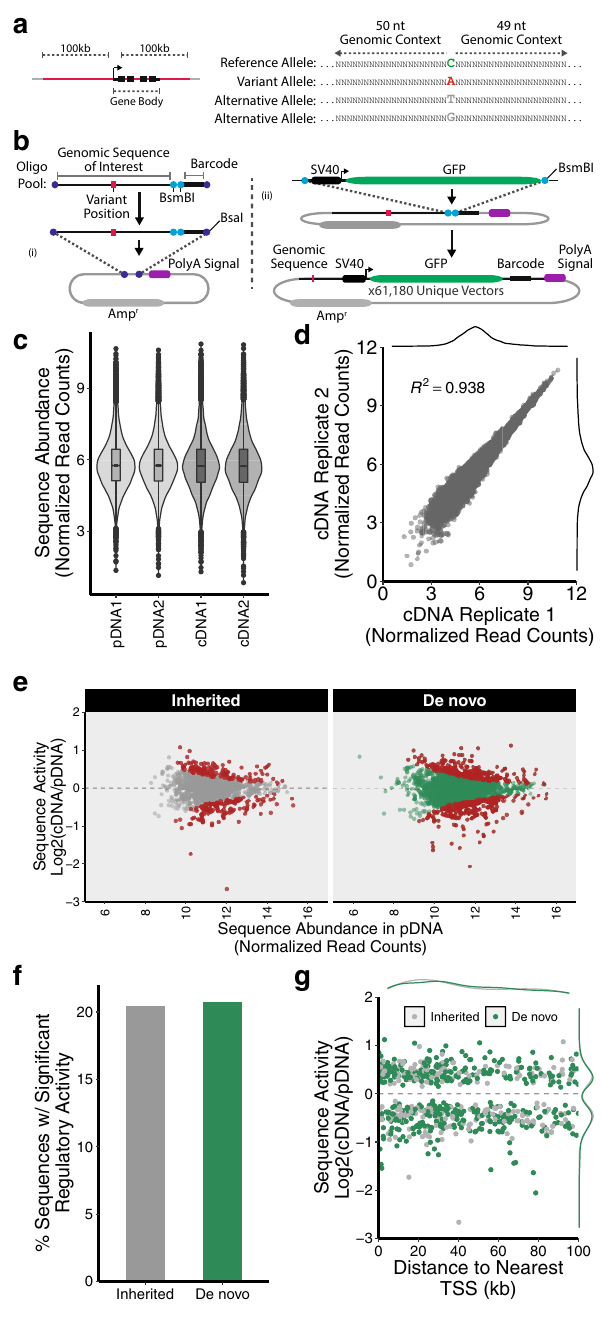
Figure 2. Profiling the regulatory capacity of genomic sequences using a massively parallel reporter assay. ( a ) Schematic of MPRA oligonucleotide library design. ( b ) Schematic of MPRA vector design and cloning. ( c ) Abundance of MPRA library elements corresponding to genomic sequences represented in the MPRA plasmid pool (pDNA, technical replicates) and expressed in HEK293T (cDNA, biological replicates). ( d ) Reproducibility of MPRA library element detection across biological replicates. ( e ) Regulatory activity of reference genome sequences profiled in MPRA (red = significant regulatory activity). ( f ) Fraction of reference genome sequences that display significant regulatory activity in MPRA. ( g ) Distance to nearest TSS for reference genome sequences that display significant regulatory